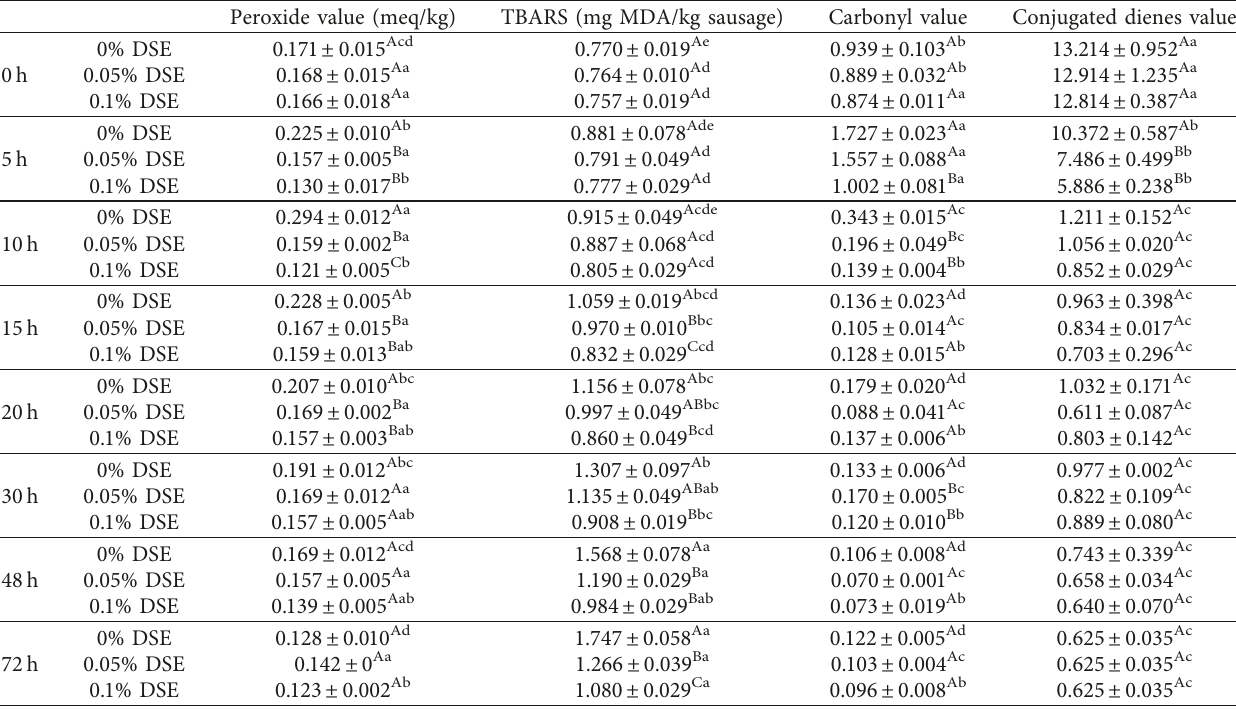
Table 1: Changes of oxidation indices in Cantonese sausage